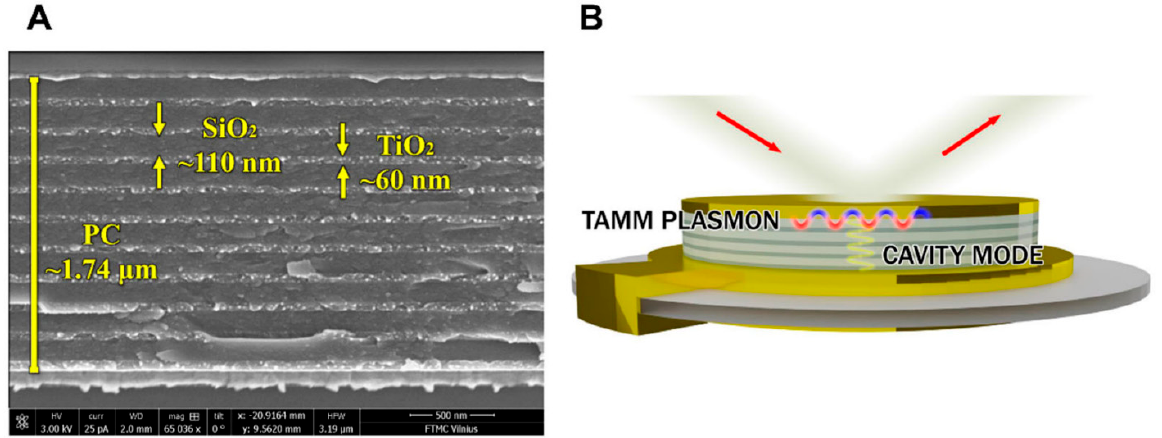
Figure 8. SEM micrograph of the plasmonic photonic structure modified QCM-D sensor chip ( A ) and Tamm plasmons and cavity mode excitation using nanometer structures of formed photonic crystal ( B ). Adopted from [106].